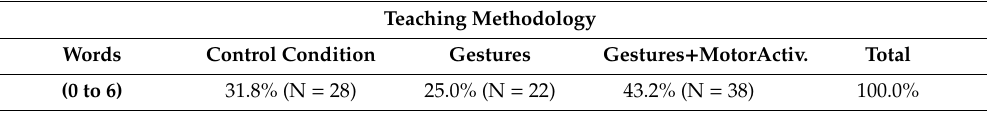
Table 2. Vocabulary known by children prior to the intervention commencing